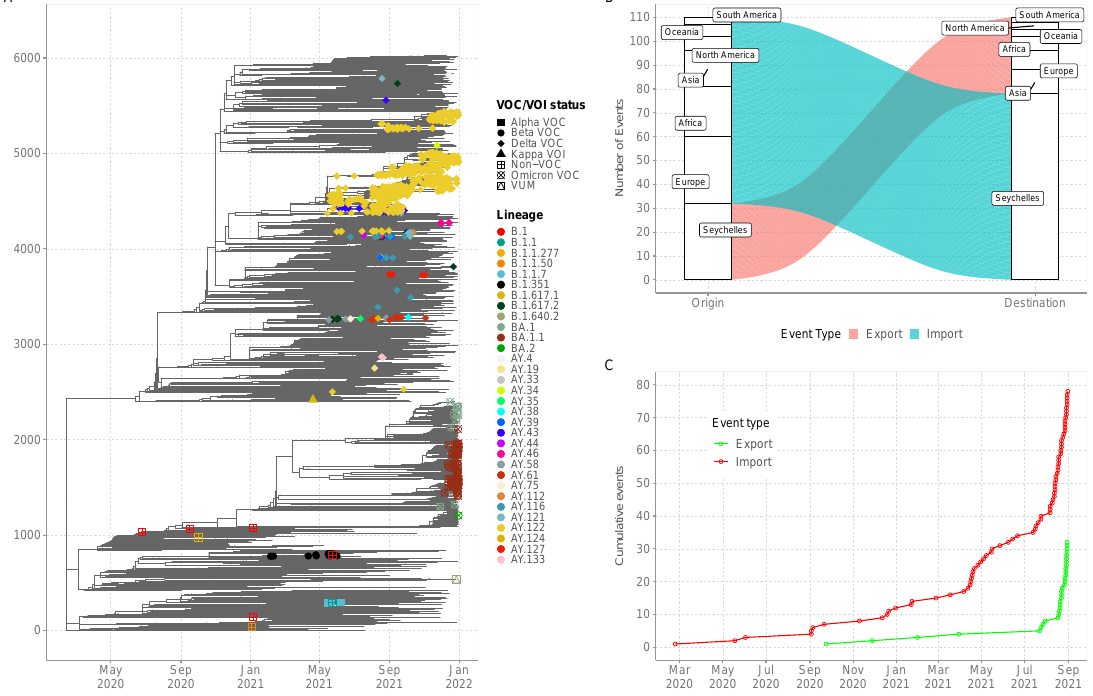
Figure 4. ( A ) Time-resolved global phylogeny that combined 1056 Seychelles sequences (coloured tip labels) and 5179 global reference sequences. ( B ) The number of viral imports and exports into and out of Seychelles. ( C ) Cumulative number of viral imports and export over time into